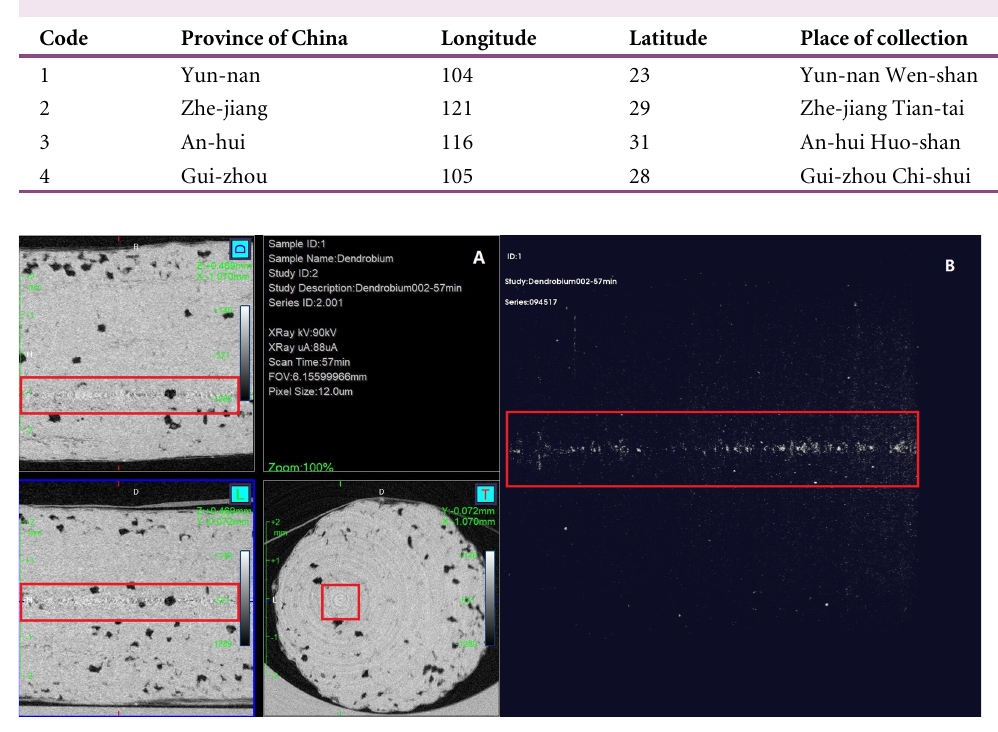
Figure 1 Transversal (T), sagittal (L), coronal (D) and reconstruction (top right) views of Dendro- bium. The rectangular box indicates the position where Raman spectra were measured. Full-size DOI: